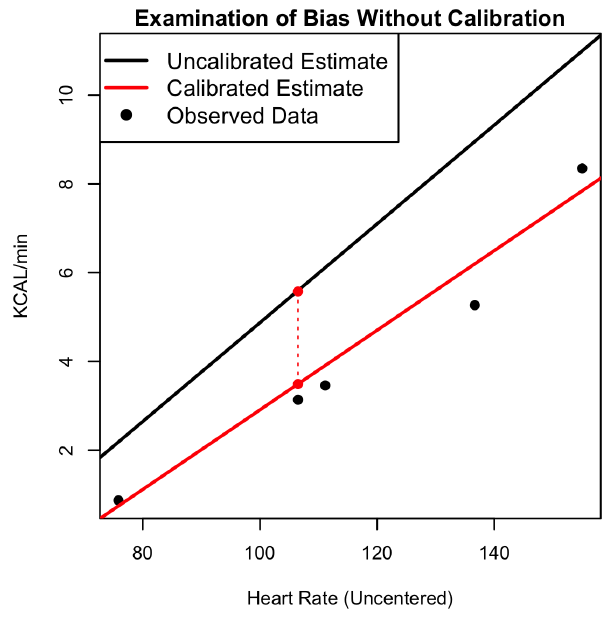
Figure 3. Figure 3 shows an Illustration of the difference between population-level and individual-level relationships between heart rate and energy expenditure. The solid black is the population equation, estimated from the subject’s age and sex, omitting subject-specific random effects; the solid red line is the subject equation including the subject-level random-effects; and the vertical dashed red line shows the difference between the population- level and subject-level equations at the slow walking heart rate.